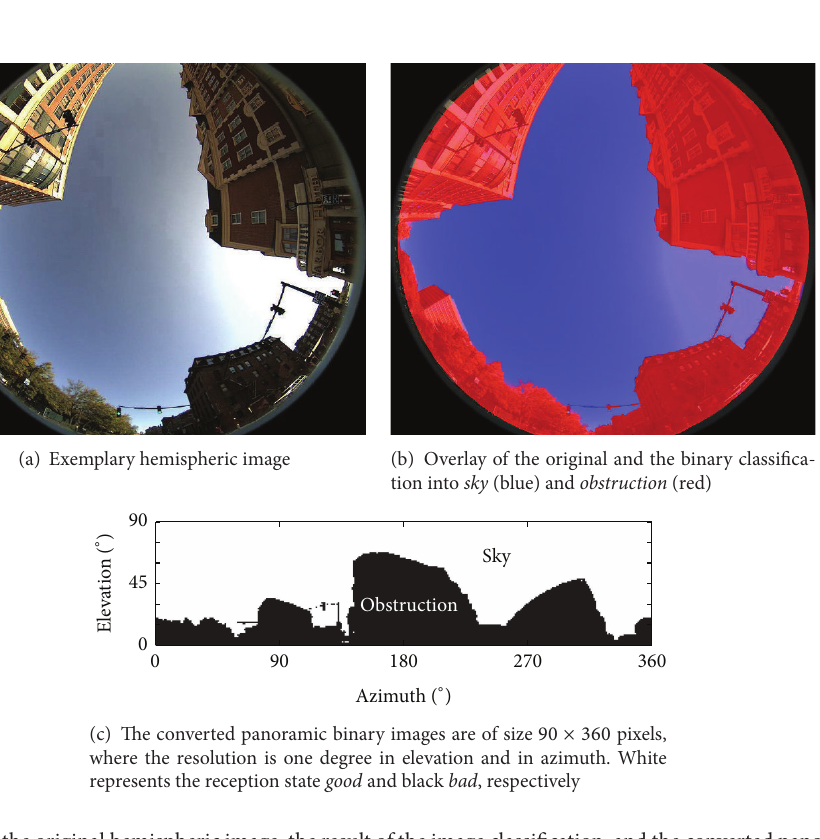
Figure 3: The images show the original hemispheric image, the result of the image classification, and the converted panoramic binary image, where the reception state good and bad is